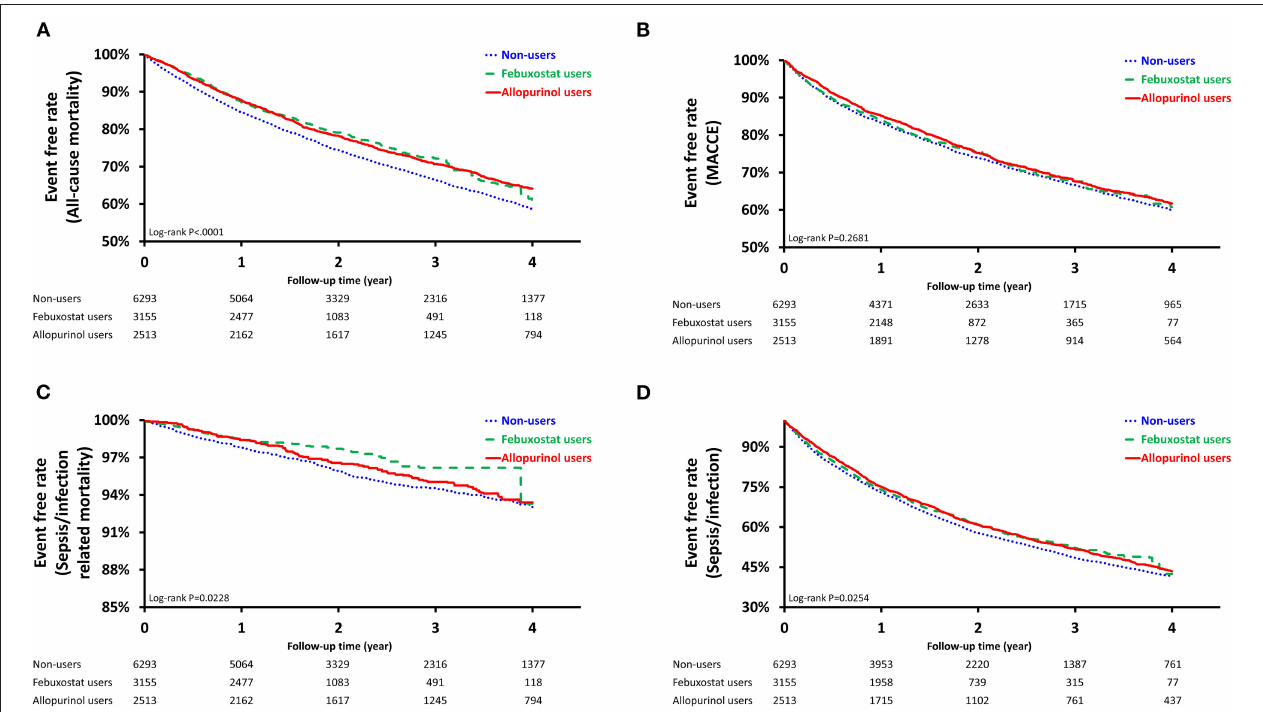
FIGURE 2 | Survival Probability of Pre-Dialysis Stage 5 CKD Patients. Survival curves were created using the Kaplan Meier estimator. (A) : Sepsis/Infection (Log-rank test, P < 0.0254); (B) : Sepsis/Infection-Related Mortality (Log-rank test, P < 0.0228); (C) : Major Adverse Cardiac and Cerebrovascular Events, MACCEs (Log-rank test, P < 0.2681); (D) : All-Cause Mortality (Log-rank test, P <